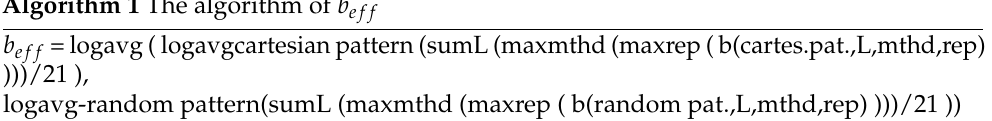
Algorithm 1 The algorithm of b ef